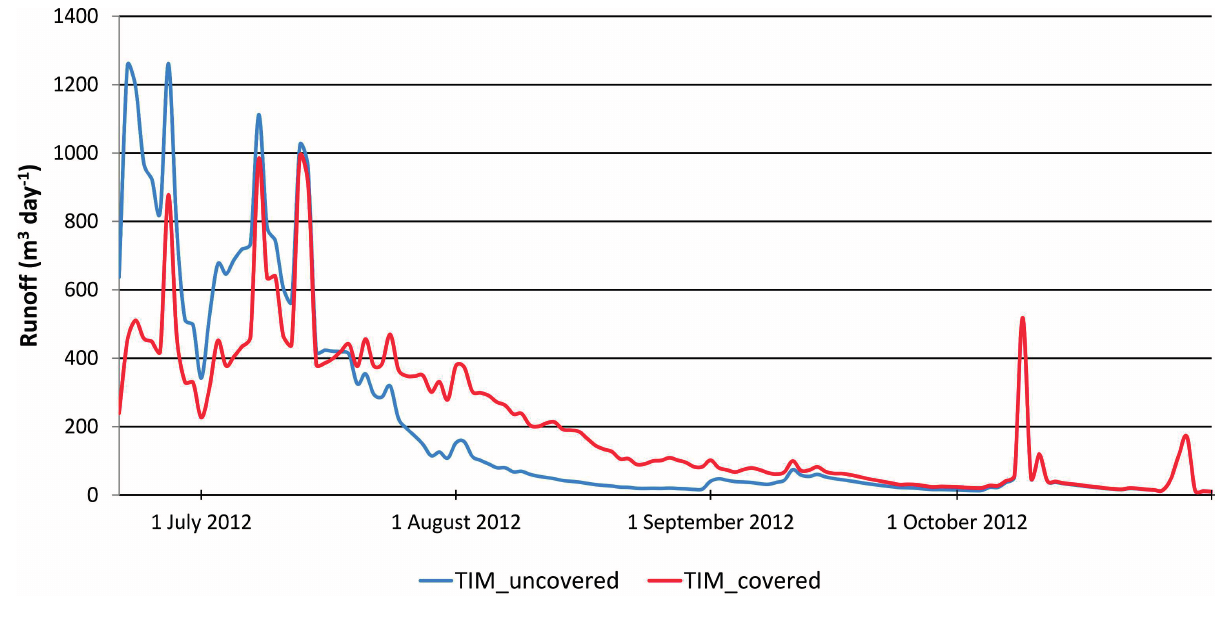
Figure 11. Daily runoff at 3200 m a.s.l. simulated for covered and uncovered snow surfaces with the temperature-index model (TIM) between 17 June 2012 and 20 October